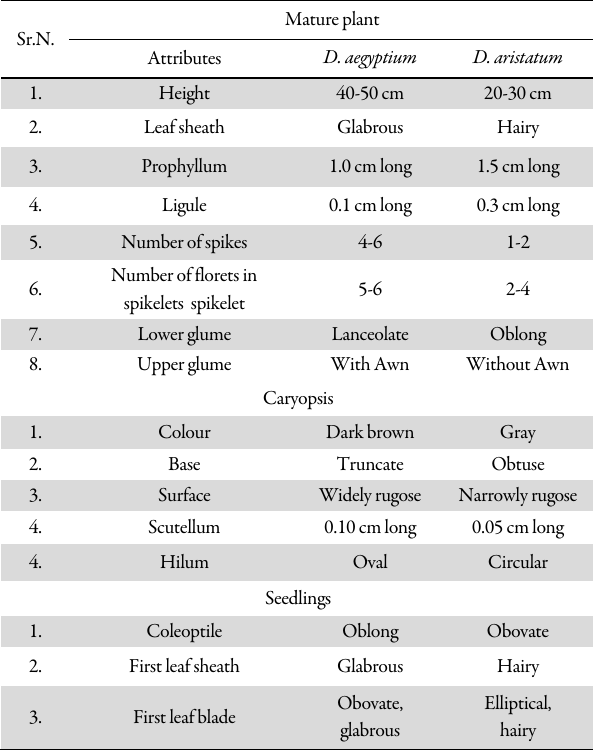
Table 1. The characters differentiation of mature plants, caryopsis and seedlings of Dactyloctenium aegyptium and D. aristatum Mature Sr.N.